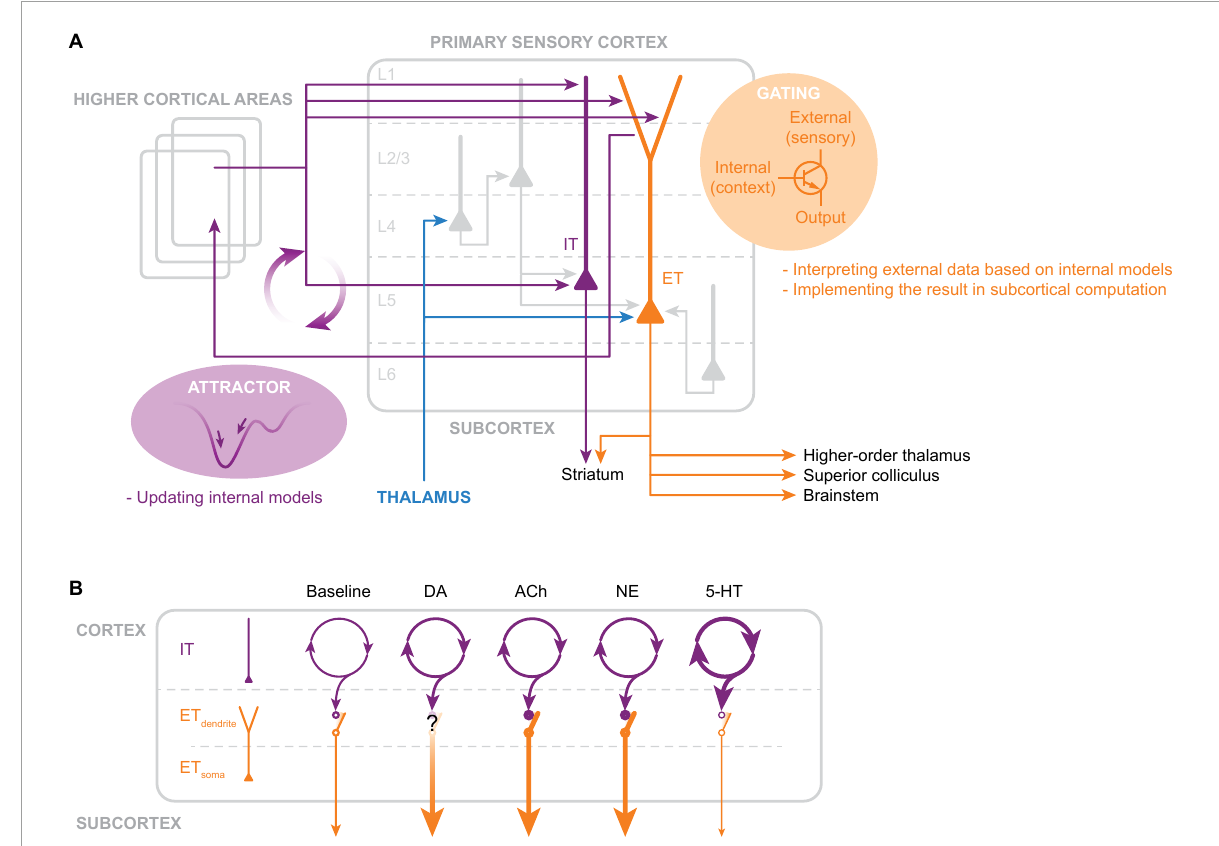
FIGURE2 Hypothesized circuits and computational roles of intratelencephalic (IT) and extratelencephalic (ET) neurons in L5. (A) IT neurons constitute a dense recurrent network within and across cortical areas. For sensory processing, the IT network integrates external sensory evidence and seeks stable states (attractors) in activity space through synaptic connections formed by past experience. Each attractor represents an internal model, with which the brain compares against incoming sensory data. Internal models are constantly updated and fed into the distal apical dendrites of ET neurons. These feedback inputs serve as gating signals that selectively enhance the output of ET neurons for sensory inputs that match with the internal model. Boosted ET outputs are broadcasted to the subcortical structures, which integrate this filtered sensory information. (B) Simplified schematic illustration of various neuromodulation acting differently on IT somatic and ET dendritic and somatic activities. Note that the illustration demonstrates the net effect of individual neuromodulators (see the Section on “Neuromodulation” for effects on various receptor subtypes and temporal dynamics). The thickness of the lines represents changes in activity due to neuromodulation (thicker lines indicate increased activity and thinner lines indicate decreased